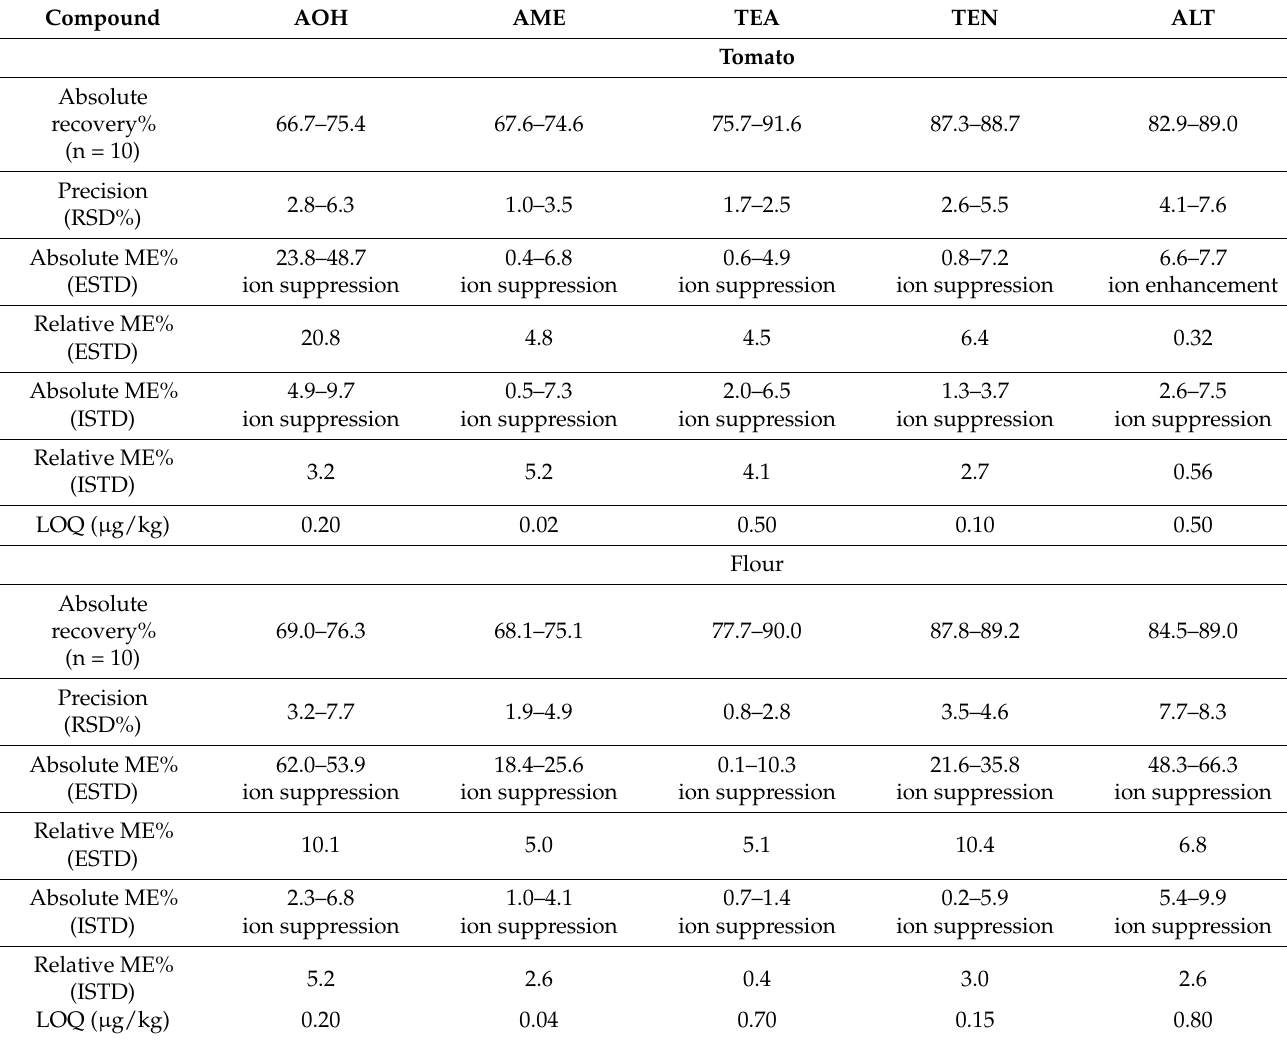
Table 3. Validation results for Alternaria toxins in tomato-based products and in flour using the dilute and shoot method. Matrix effect (ME) was evaluated for both matrices using the ESTD (external standard) and ISTD (internal standard)